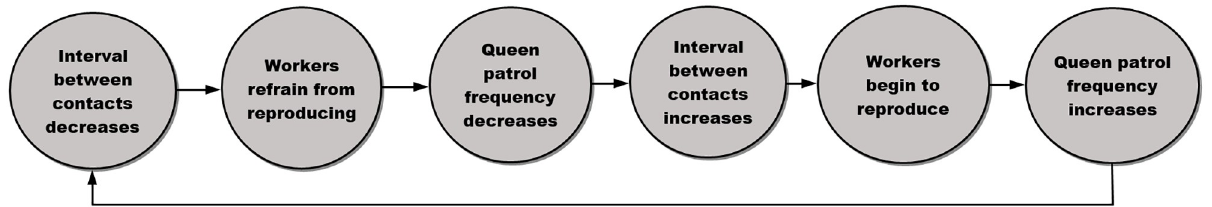
Fig 1. Feedback loop diagram. A feedback loop between the queen’s patrol behaviour and the reproductive activity of workers.